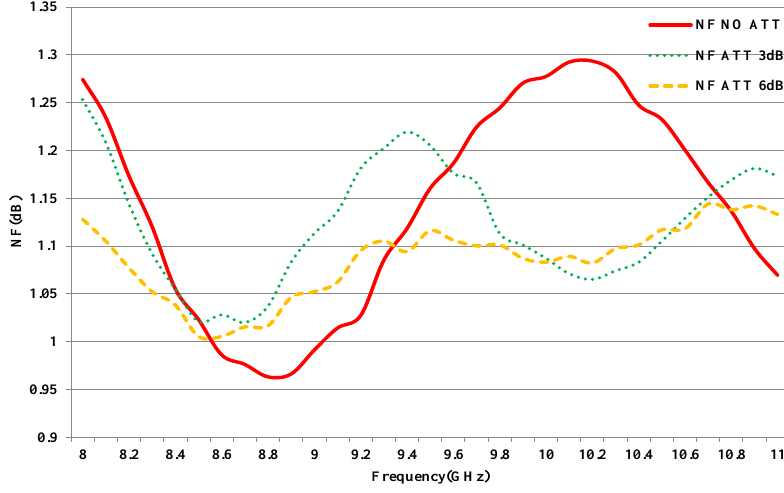
Figure 10. NF result influenced by source match.